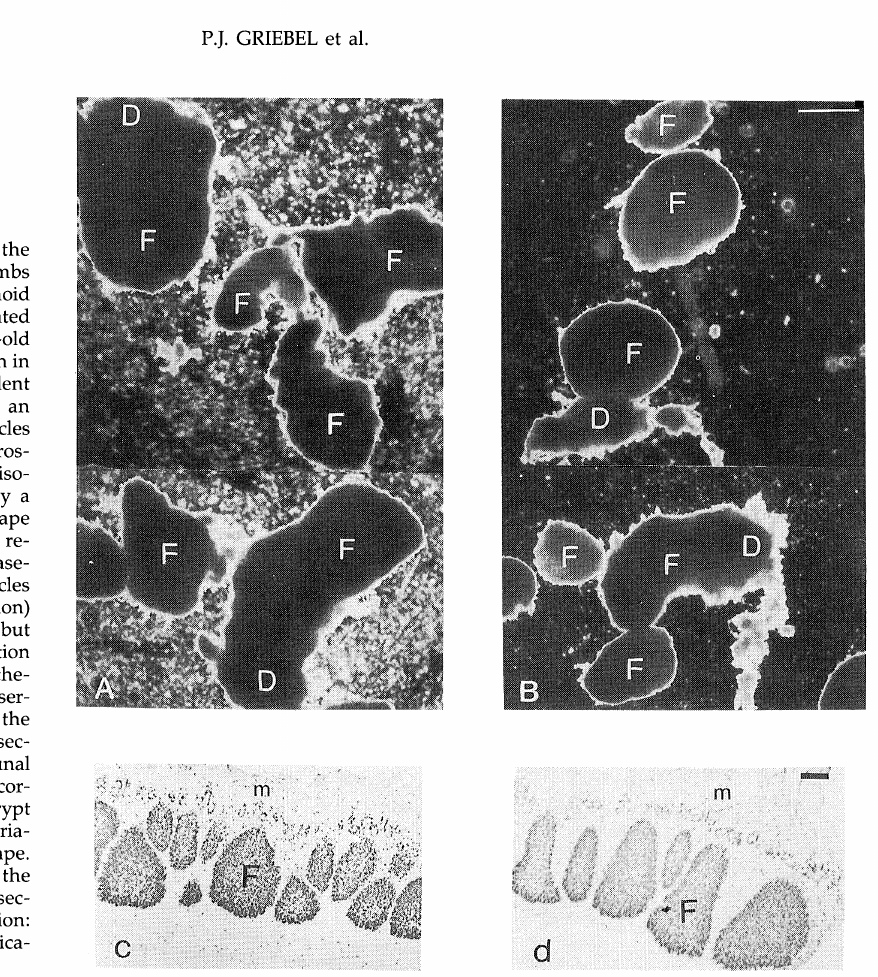
FIGURE 5. Lymphoid follicles in the PPs of foetuses and young lambs